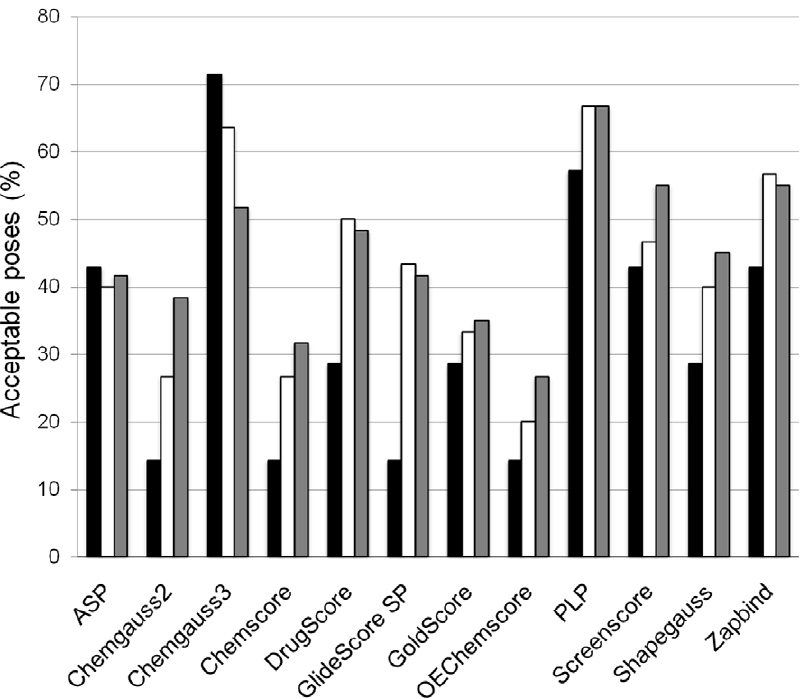
Figure 6. The proportion of acceptable poses highly ranked by each of the scoring functions. The percentage of poses with RMSD values less than 2.0 A˚ compared to the pose found in the crystal structure among the highest ranked (black), among the top five (white) and among the top ten poses (grey) is presented. Since there were few acceptable poses of C5231, the ligand was only considered in the calculation of the percentage among the highest